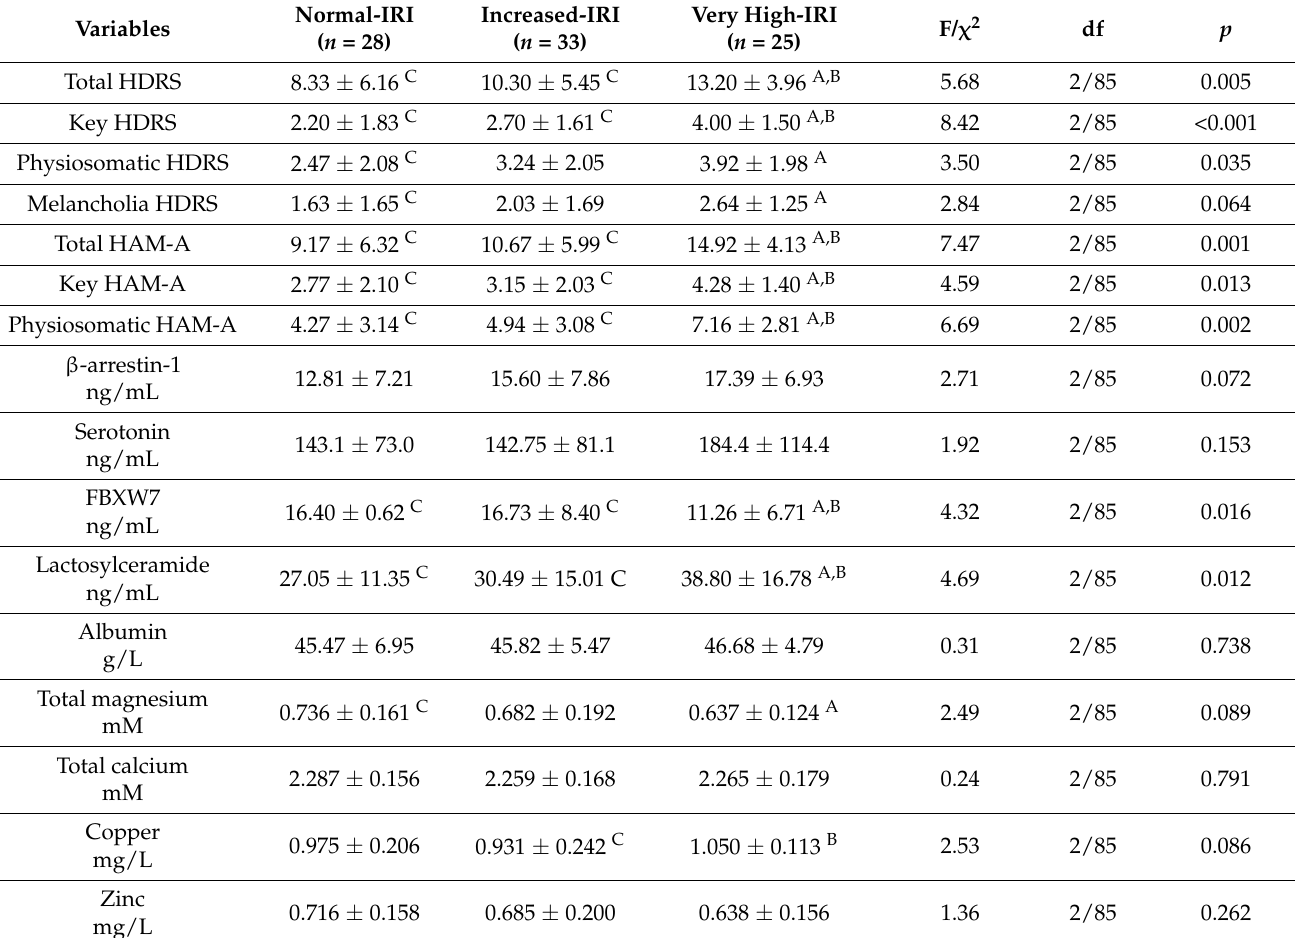
Table 2. Measurements of the Hamilton Depression Rating Scale (HDRS) and Hamilton Rating Scale for Anxiety (HAM-A) total and subdomain scores and biomarkers in patients with type 2 diabetes mellitus (T2DM), subdivided into those with normal insulin resistance index (IRI) values, medium increased IR, and very high IR